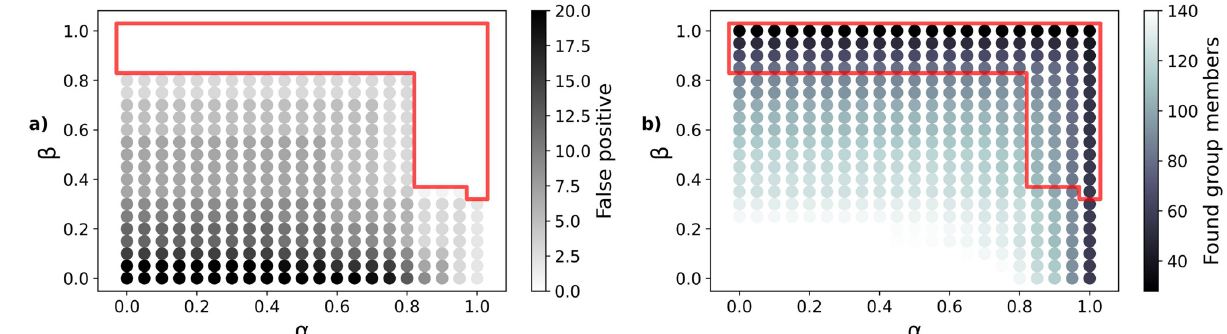
Fig 2. Parameter study. a) Number of false positive in the detection of group members by different values of α and β . White colours indicate that no false positives were found. b) Number of detected members of social groups. Light colours show high numbers of found members. The red area highlights the sets of parameters where the number of false positives in a) is